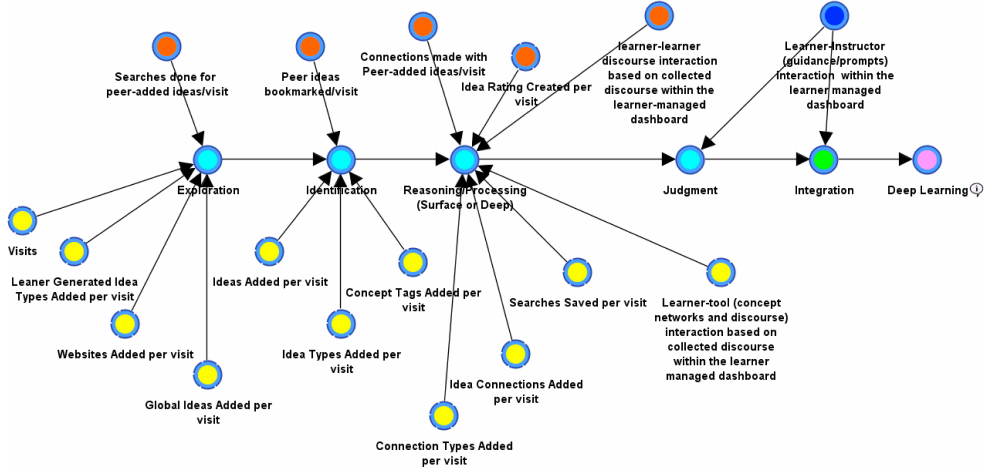
Figure 2. Learning analytics model of reflective sensemaking.